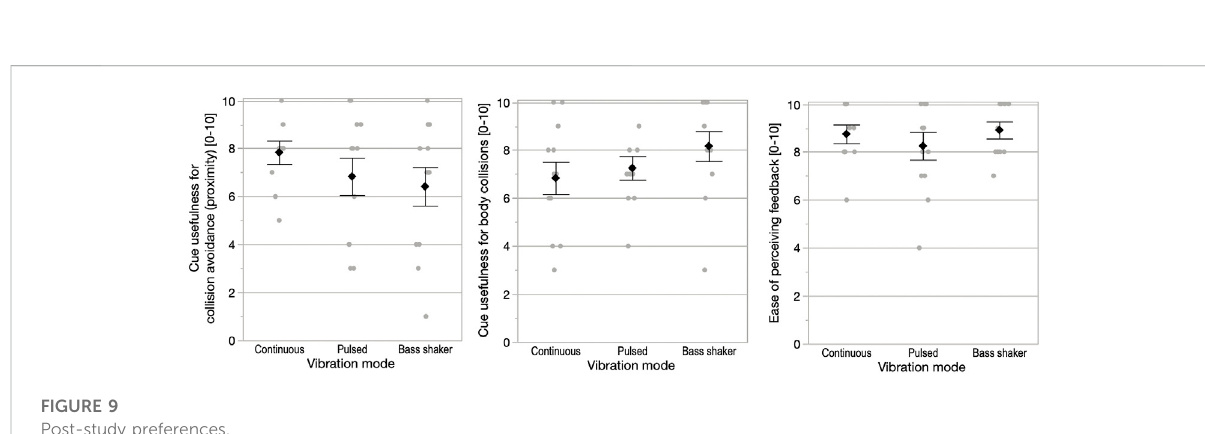
FIGURE 9 Post-study preferences.